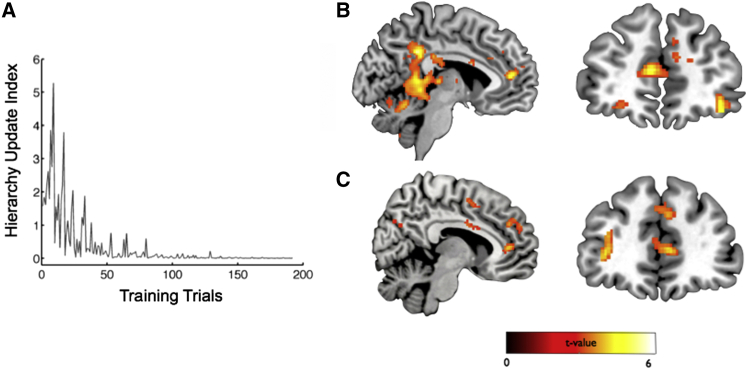
Learn Phase: MPFC Activity Correlates with SMC-Modeled Hierarchy Update Signal Selectively in Self Condition(A) Illustrative example from one subject showing profile of SMC-modeled hierarchy update index during training trials (see Supplemental Experimental Procedures for details).(B) Whole-brain analysis: significant correlation between activity in MPFC and hierarchy update index in Self condition (sagittal and coronal views: MNI x, y, and z coordinates −6, 46, and 12; Z = 4.22, p < 0.001 uncorrected and SVC p = 0.0040) (Table S3B).(C) Significantly greater correlation between MPFC activity and updating of objective measure of hierarchy knowledge (i.e., negative log likelihood of responding correctly on all possible pairs of individuals) in Self compared with Other condition: sagittal (left) and coronal (right) sections shown (MPFC x, y, and z coordinates 2, 44, and 8; Z = 3.87, p < 0.001 uncorrected and SVC p = 0.021). Display threshold is p < 0.005 uncorrected.